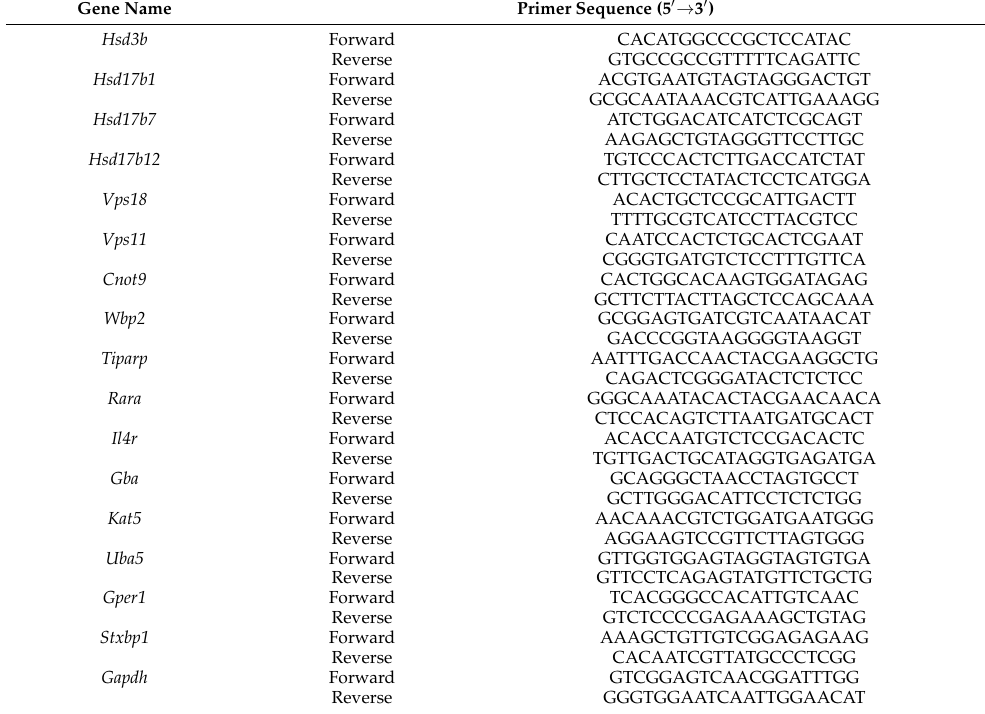
Table 1. Primer sequence for